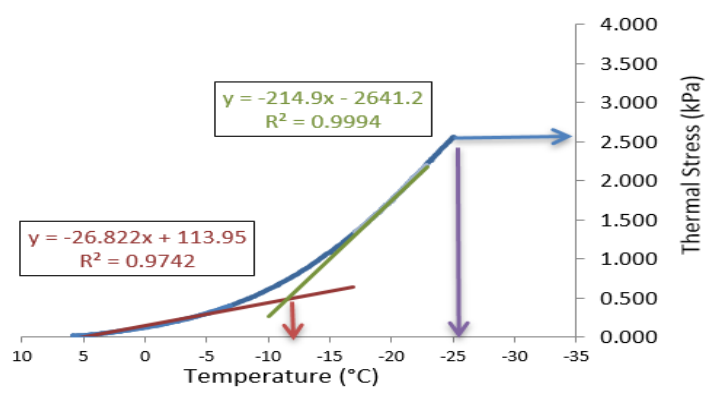
Figure 17. TSRST for control mix.